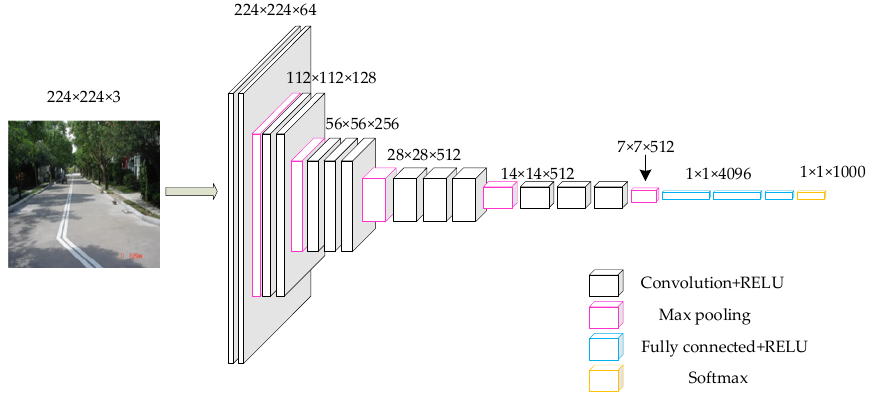
Figure 5. The structure of VGG ‐ 16 CNN. The input color image size is 224 × 224 × 3, and the output layer uses Softmax to classify the road surface type.